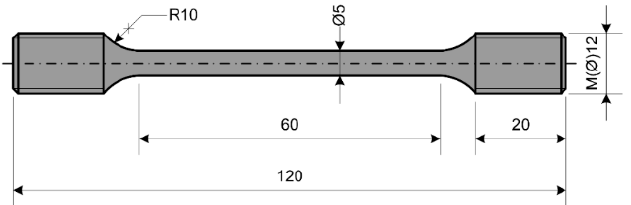
Figure 1. Specimen’s geometry–tensile test.